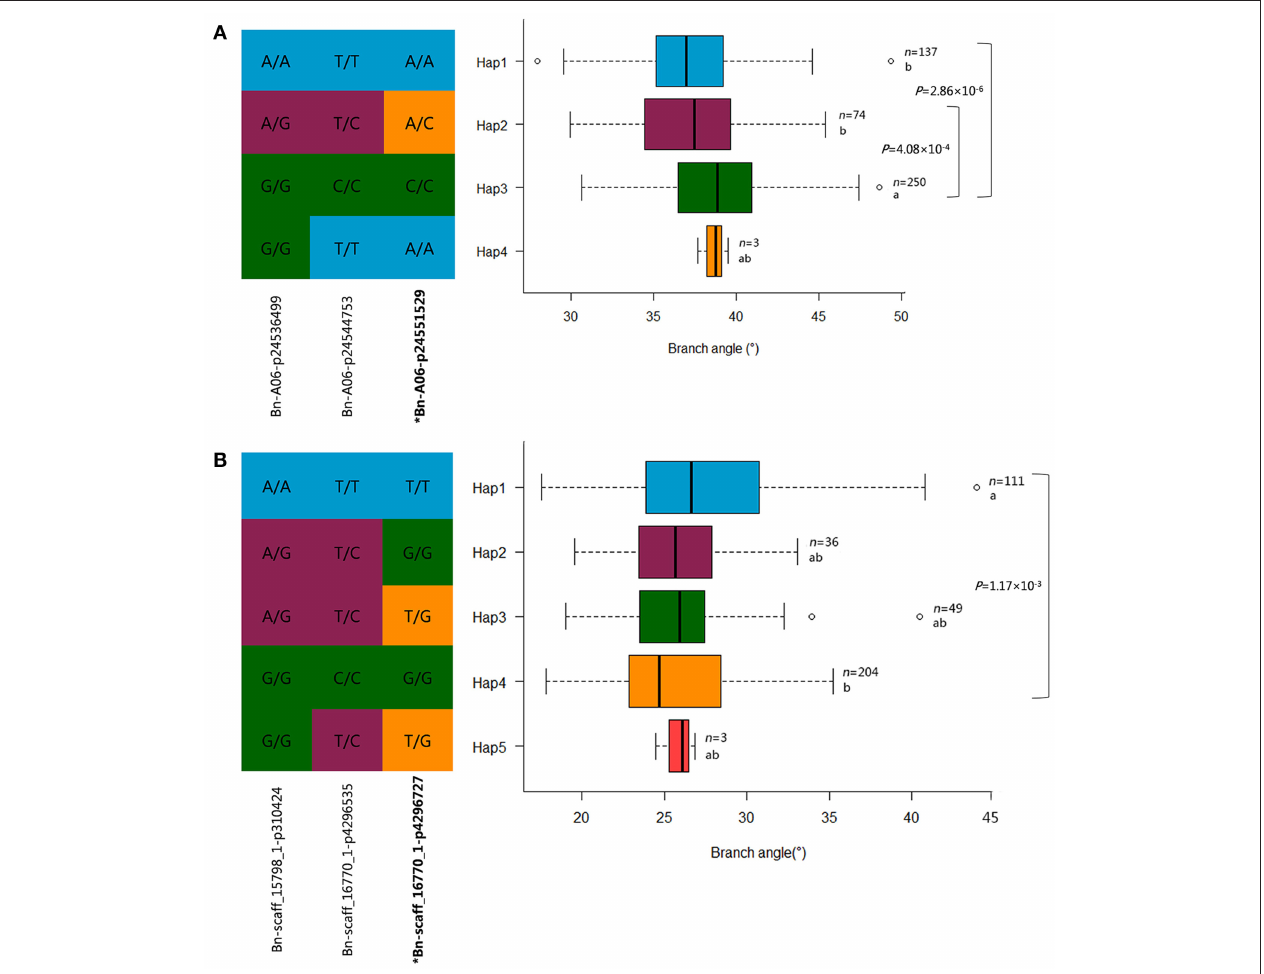
FIGURE 7 | Haplotypes of associated SNPs among rapeseed natural variations. (A) Haplotype analysis of the peak SNP Bn-A06-p24551529 for Bna.SGR3 in MLM. (B) Haplotype analysis of the peak SNP Bn-scaff_16770_1-p4296727 for Bna.SGR1 in MLM. n denotes the number of genotypes belonging to each haplotype group, and the genotypes less than three are not shown. Statistical significance was determined with a t -test, different letters represent significant a difference at 5% level. The branch angle distribution of each haplotype group is displayed with a box